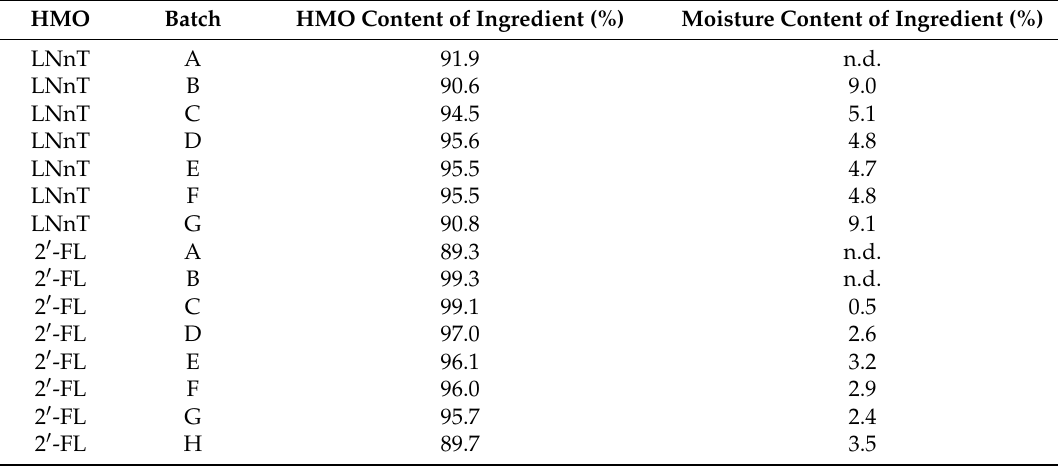
Table 1. Human milk oligosaccharides (HMO) content of different batches of HMO. HMO Batch HMO Content of Ingredient (%) Moisture Content of Ingredient (%) LNnT A 91.9 n.d. 90.6 9.0 94.5 5.1 95.6 4.8